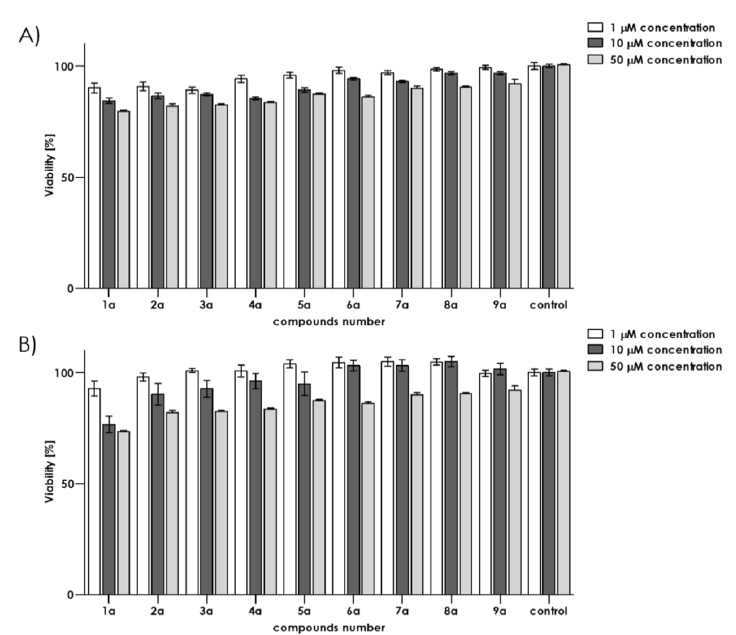
Figure 1S. Scheme of synthesis of compound